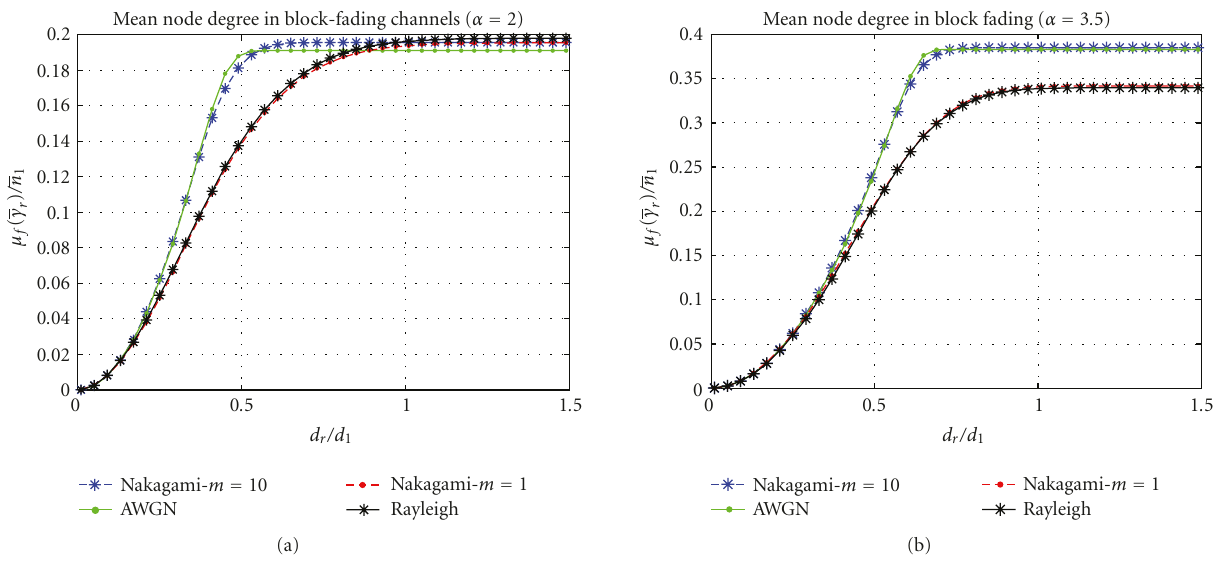
Figure 10: Related mean node degree in Nakagami- m , AWGN, Rayleigh channels as function of the reliability range d r , with α = 2 (a) and α =